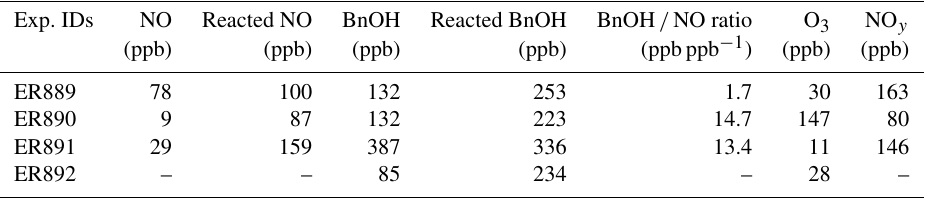
Table 2. Steady-state GP and reacted BnOH and NO concentration during the irradiation. Exp. IDs